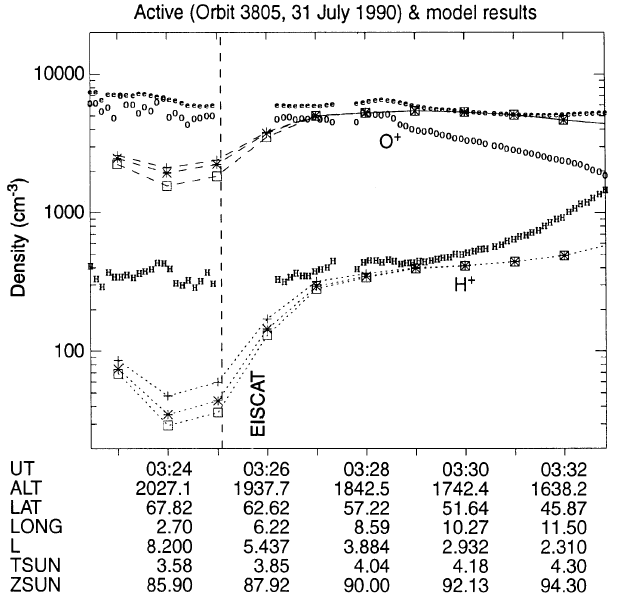
Fig. 7. As in Fig. 5, but for the effect of different photoelectron escape energy fluxes as shown already in Fig. 4 for the vertical profiles